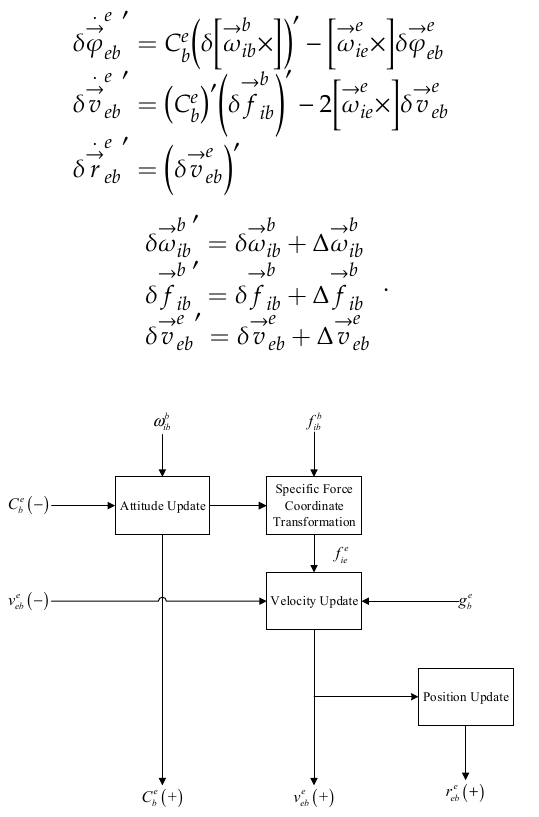
Figure 2. Navigation parameters update process for the